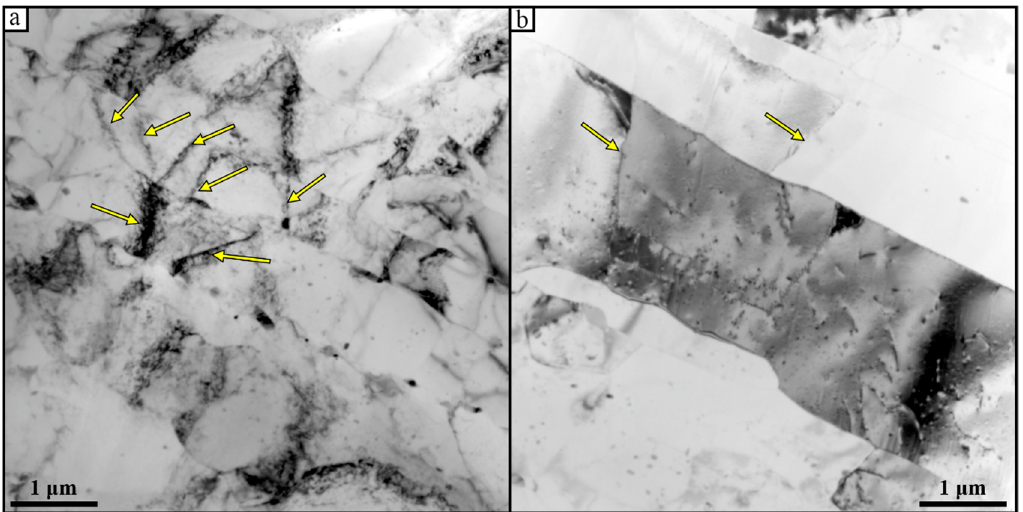
Figure 10. TEM images of the TMAZ structures in the 35 mm ( a ) and 30 mm ( b ) thickness seams.